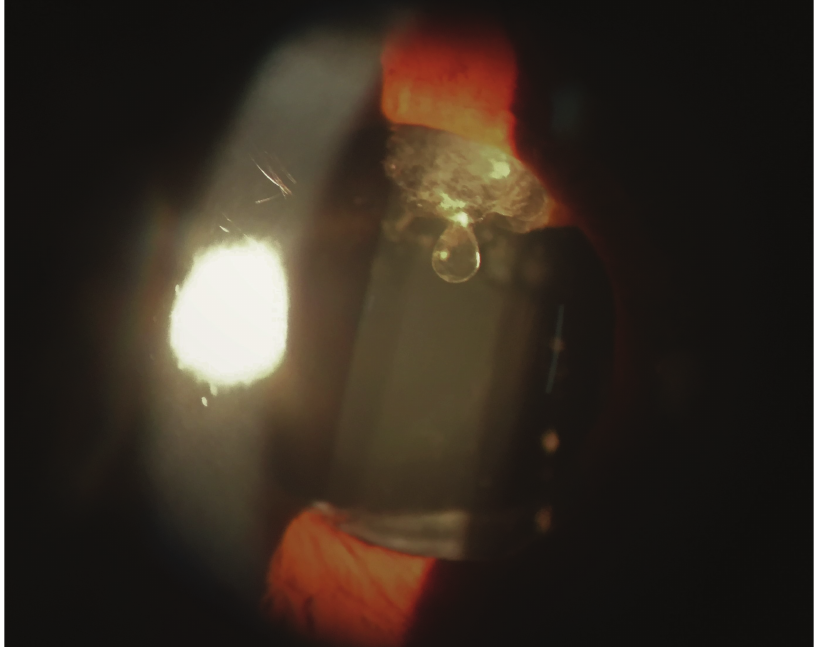
Figure 1. Biomicroscopic photograph showing the Elschnig pearls in the left eye. This original image was captured using an iPhone 6 camera mounted with an adapter to a Topcon® slit lamp biomicroscope (Topcon Medical Systems Inc., Oakland NJ). (Tiger Lens is unavailable to provide any information to me other than the website.)